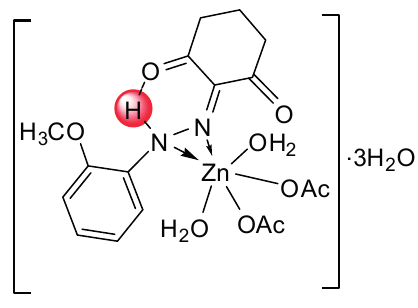
Figure 5. Structure of [Zn(L 1 )(OAc) 2 (H 2 O) 2 ]·3H 2 O